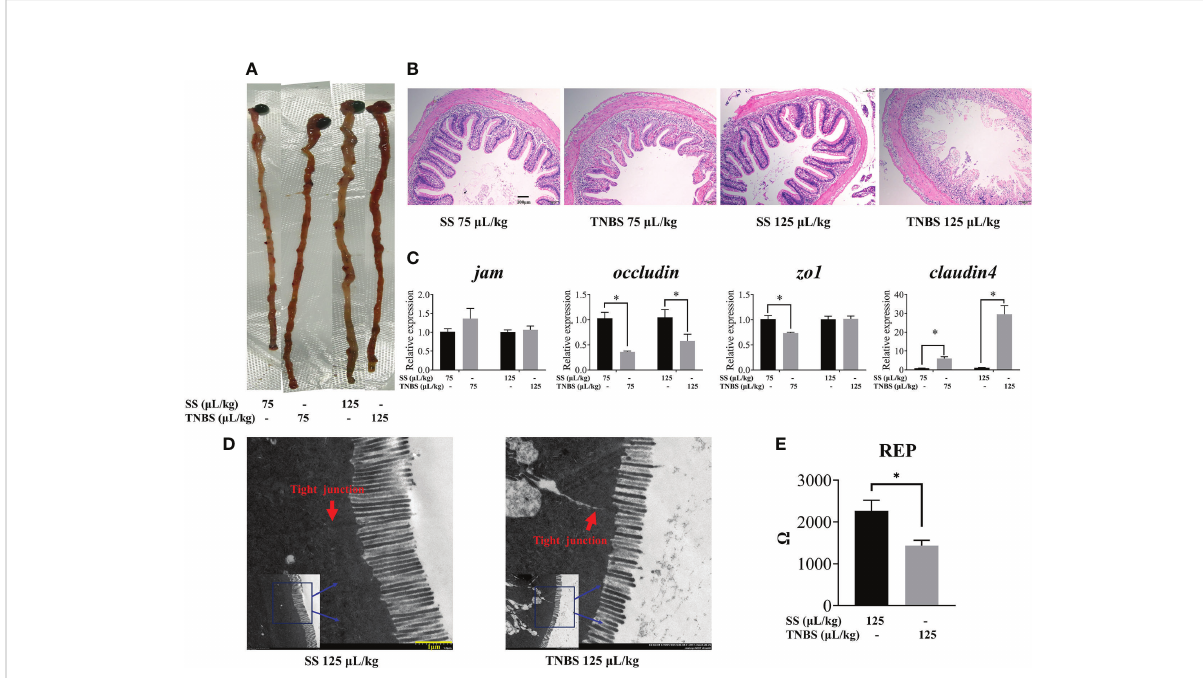
FIGURE 1 The effect of TNBS on the intestinal morphology and tight junction. (A) Gross picture of intestinal. (B) Each group ’ s representative microphotograph of H&E staining paraf fi n-embedded sections of gut was shown (scale bar: 100 m m). (C) Relative mRNA levels of tight junction related genes. (D) 125 m L/kg SS and 125 m L/kg TNBS representative transmission electron microscope image of intestinal (scale bar: 1 m m). Red arrows represent the tight junction. (E) Gut epithelial resistance of 125 m L/kg SS and 125 m L/kg TNBS. All data are expressed as mean ± S.E.M. (N = 6 at least). P value was calculated by Student ’ s t tests. * P < 0.05, compared with PBS